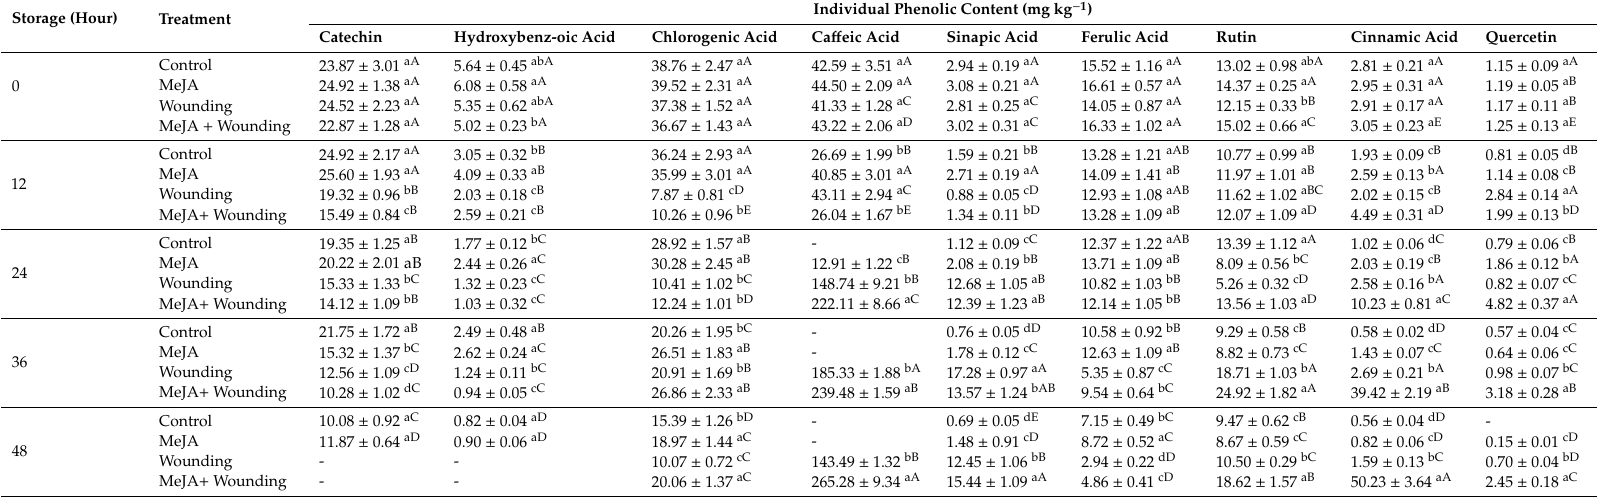
Table 1. E ff ect of MeJA treatment and wounding stress on the content of individual phenols of broccoli during 48 h of storage at 20 ◦ C. Storage